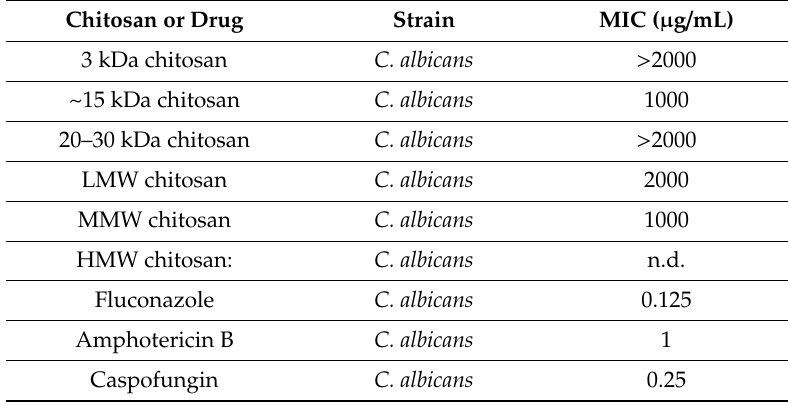
Table 1. Minimum inhibitory concentrations (MICs) of chitosans with di ff erent MWs and deacetylation degrees in combination with antifungal drugs against C. albicans SC5314.